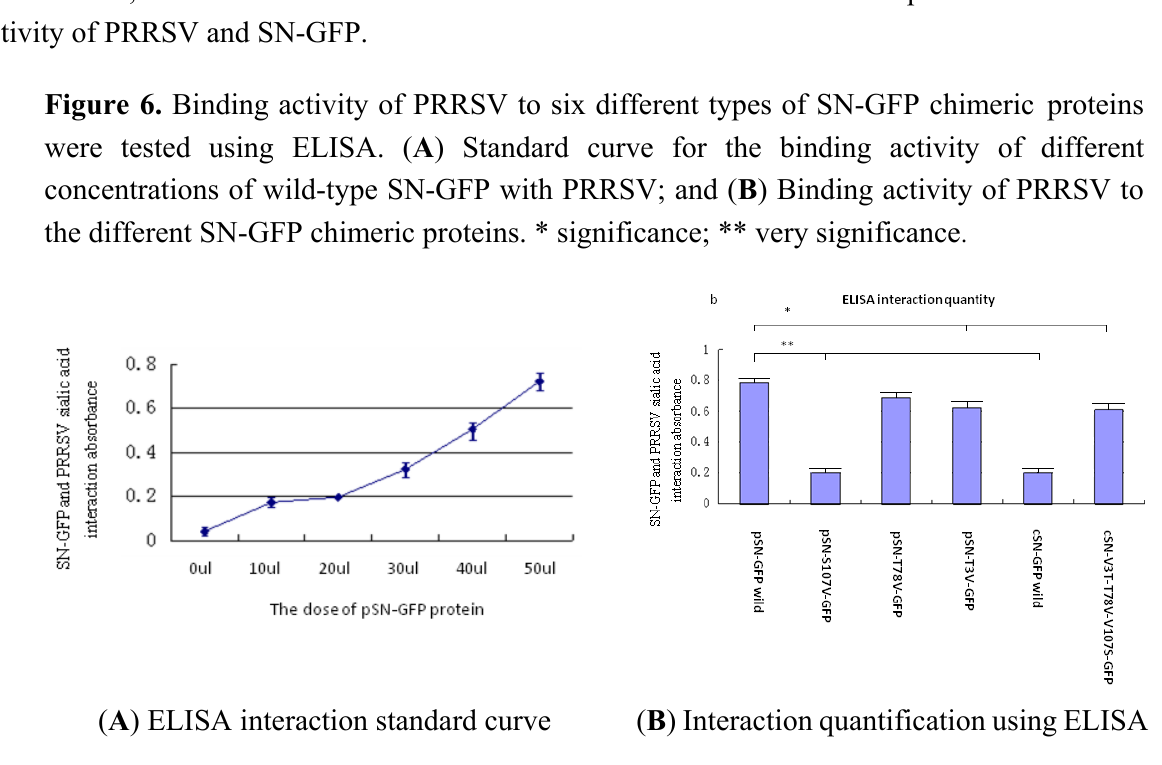
Figure 7. Analysis of the PRRSV binding activity of SN-GFP-M chimeric protein expressed in 293T cells using an immunofluorescence assay. ( A ) The SN-GFP-M chimera protein was located in the cytoplasm and on the membrane of 293T cells, as shown by DAPI staining (40× magnification); ( B ) Wild-type pSN-GFP-M chimera protein was expressed (left panel) and bound by PRRSV labeled with rhodamine red (right panel), 40× magnification; and ( C – I ) The left figure panels show the expression of SN-GFP-M in 293T cells, and the right figure panel indicates if binding of the different SN-GFP-M to PRRSV has occurred. “+” denotes binding of SN-GFP-M to PRRSV; and “ − ” denotes lack of binding between SN-GFP-M and PRRSV.